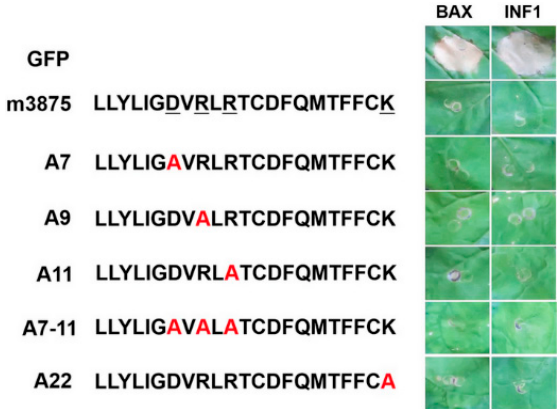
Figure 4. Effect of alanine point mutations on m3875-mediated PCD suppression. The charged amino acids, D 7 , R 9 , R 11 , and K 22 , within m3875 were individually substituted with alanine that is highlighted in read letter, resulting in A7, A9, A11, A7-11, and A22 (Left panel). Through agroinfiltration, the four m3875 mutants were transiently expressed in the Nicotiana benthamiana leaves 24 h prior to infiltration with A. tumefaciens cells harboring the BAX or INF1 gene, and the photos were taken at 5 days post BAX- or INF1- infiltration (Right panel).